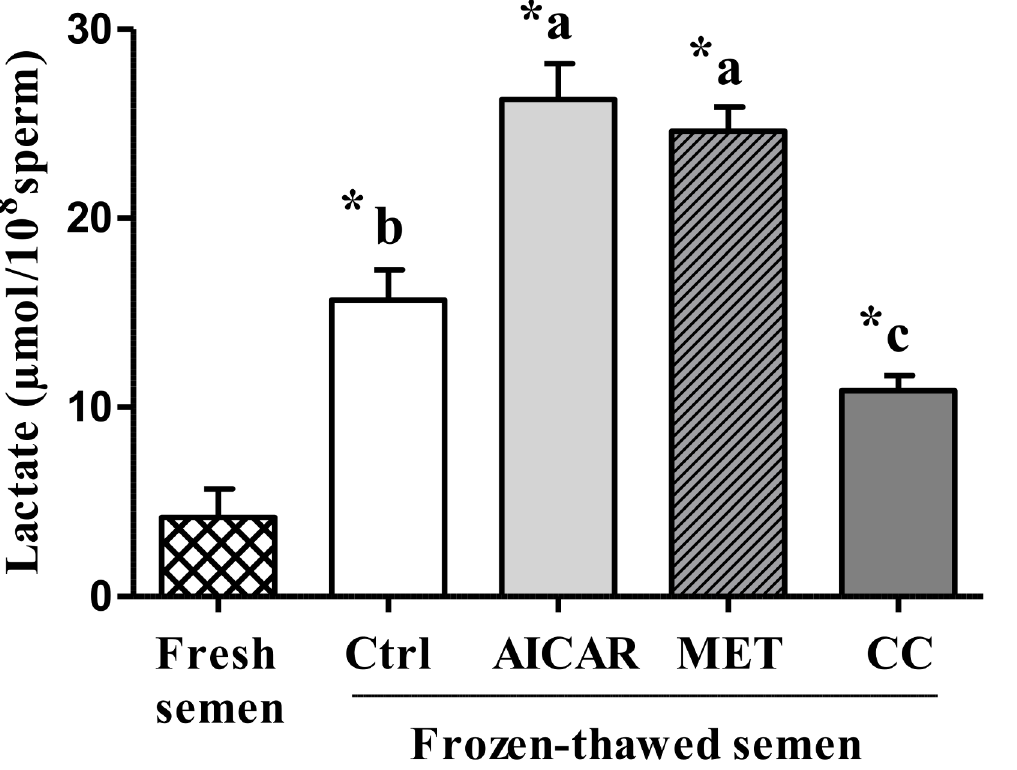
Fig 5. Effect of AMPK modulators (AICAR, MET and CC) on frozen-thawed sperm lactate production. Sperm were treated in the presence of an AMPK activator (2mM AICAR (in light gray) or 1mM MET (in diagonals)) or an AMPK inhibitor (5 μ M CC (in dark gray)) or Control (Ctrl, in white); Fresh semen (checkered pattern). Values represent means ± SEM from 6 different experiments (4 samples/experiment). Different superscripts indicate significant differences between Ctrl and treatments (AICAR, MET or CC) in frozen-thawed semen ( a,b,c , P < 0.01). Asterisks indicate statistically significant differences between fresh and frozen-thawed semen ( * , P < 0.001).